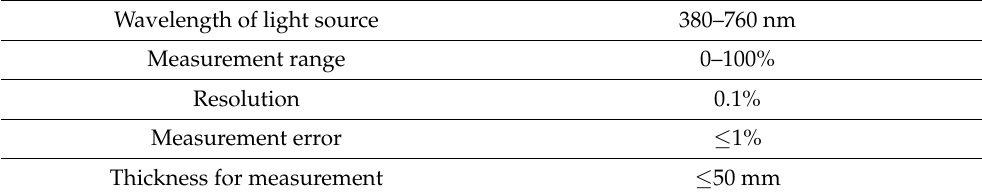
Table 8. Measurement parameters of